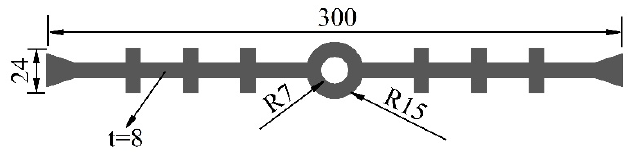
Figure 8. Waterstop I (unit: mm).